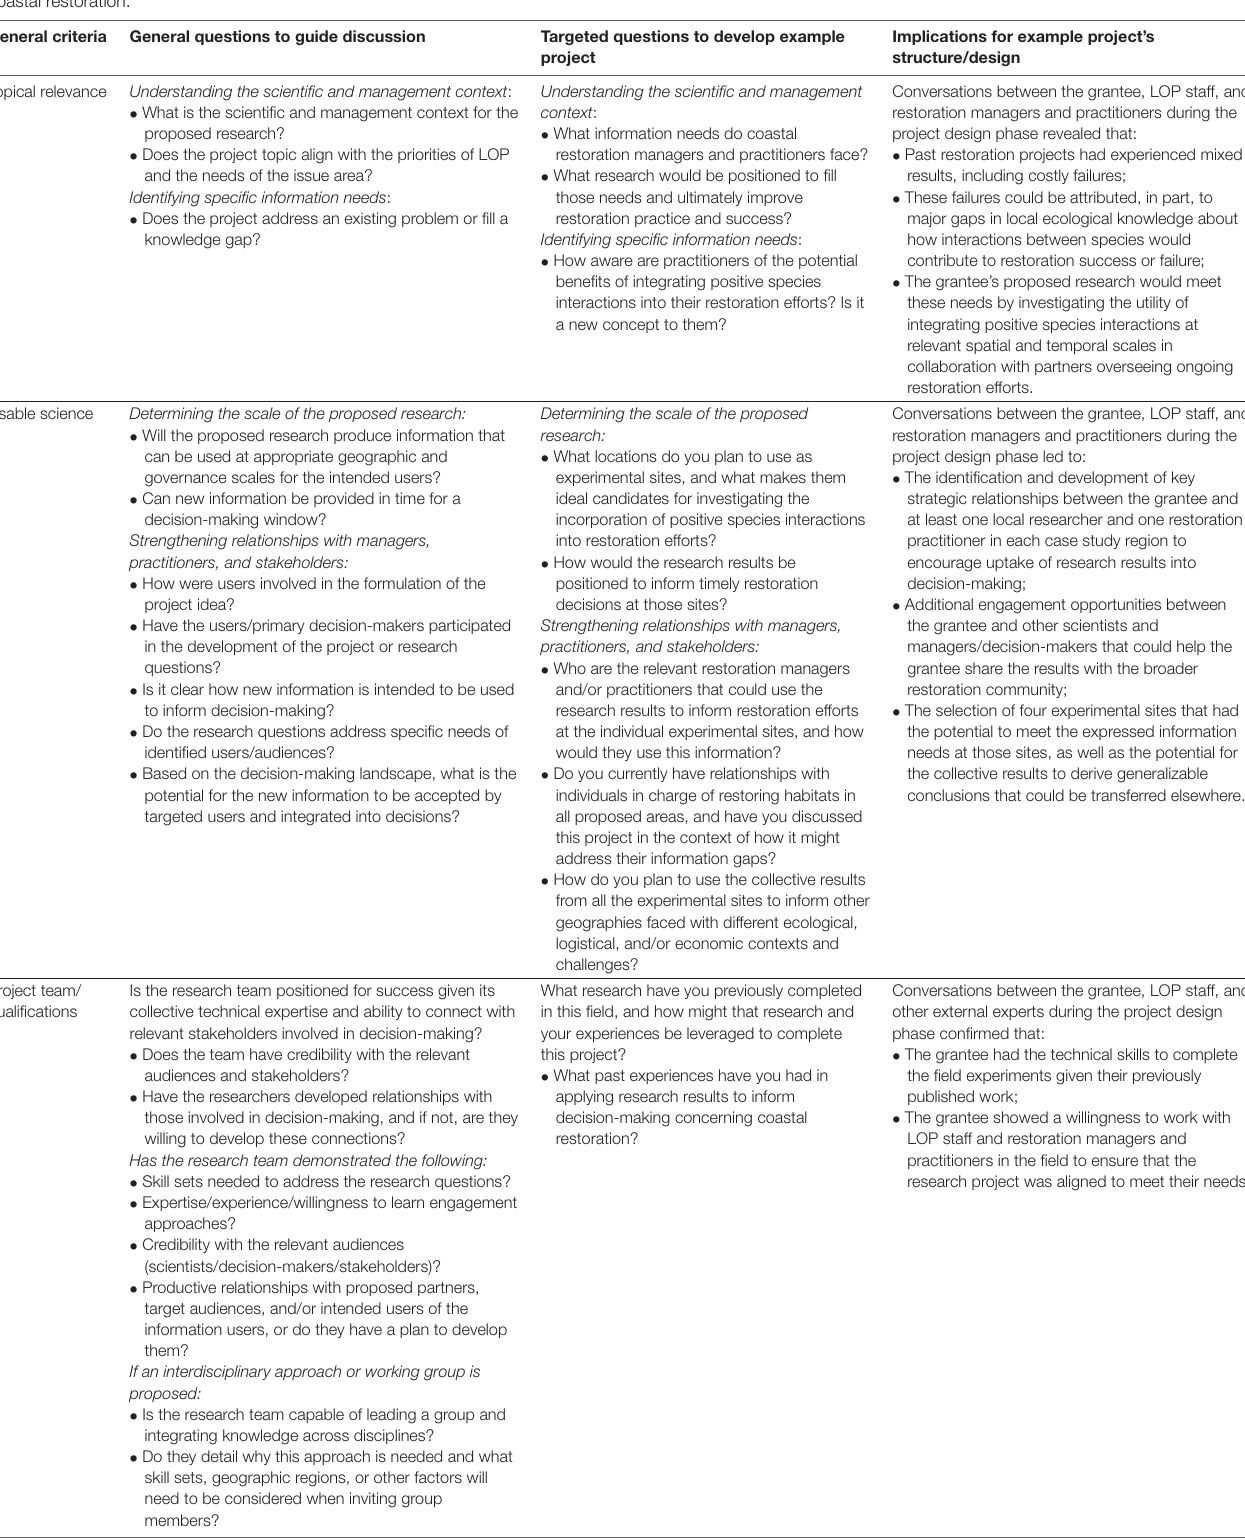
TABLE 1 | Lenfest Ocean Program’s general evaluation criteria and guidance questions used to develop useful and usable research projects followed by targeted questions and implications as they were applied to a funded project aimed at improving coastal habitat restoration by integrating ecological concepts into coastal